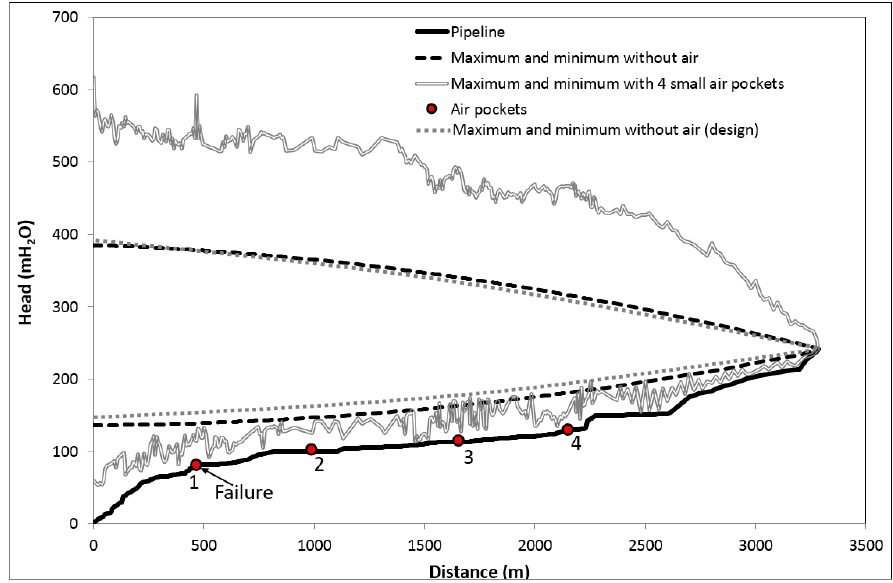
Figure 8. Comparison of maximum and minimum head envelopes with and without air in the investigated pipeline.